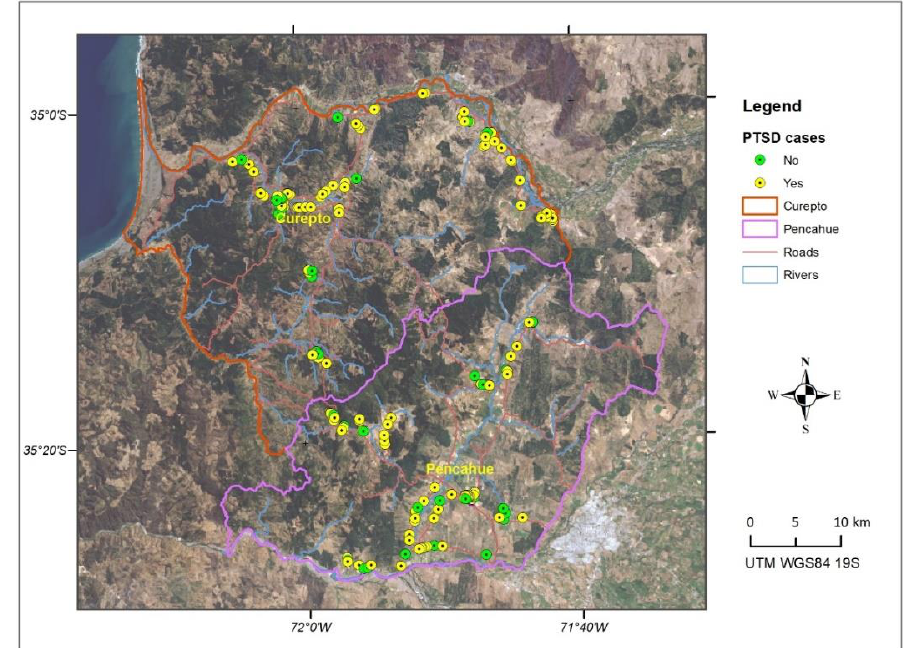
Figure 5. Spatial distribution of PTSD cases.